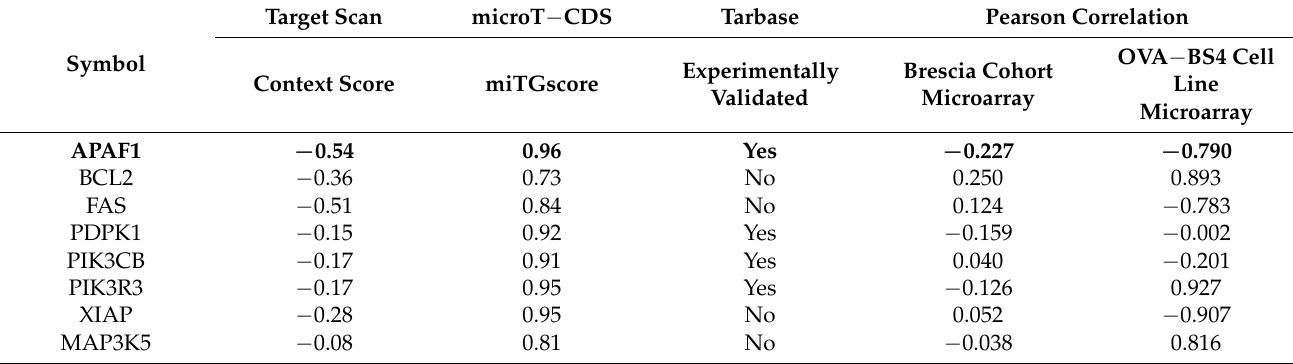
Table 7. Predicted miR-23a-3p targets involved in platinum drug resistance pathway. Reported are TargetScan, microT-CDS scores and Pearson correlations between matched mRNAs and miRNA microarray expression profiles in the Brescia cohort (73 samples: 39 Pt-r, 34 Pt-s) and OVA-BS4 cell line (6 biological replicates: 3 spheroids vs. 3